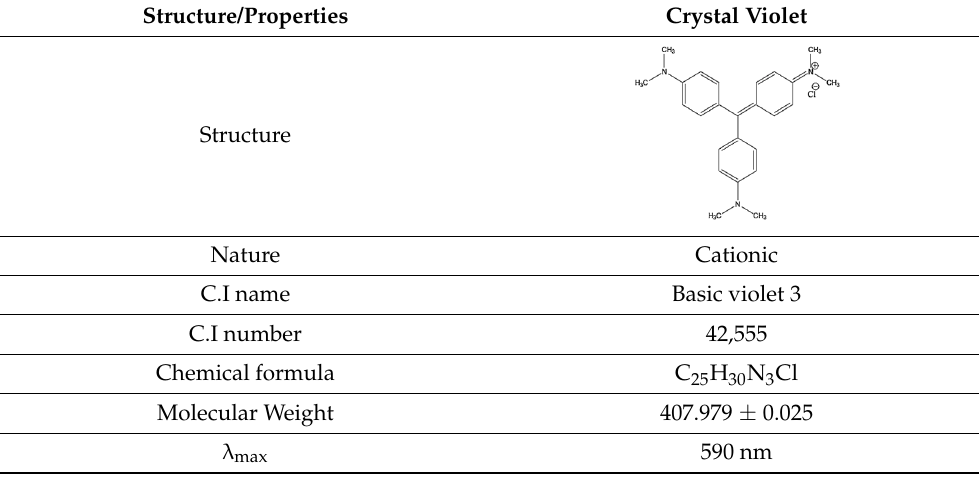
Table 1. Structure and chemical characteristics of Crystal violet dye.